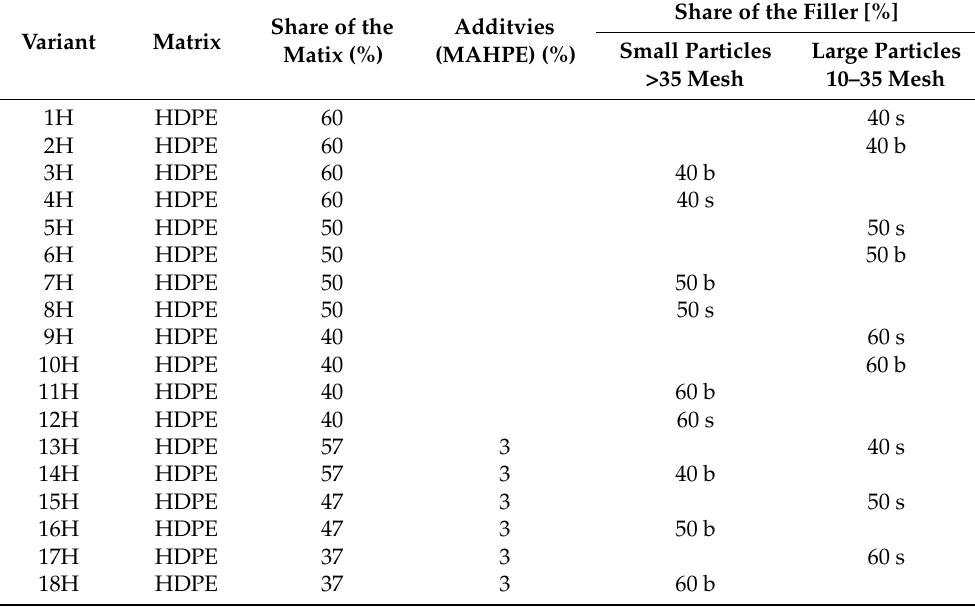
Table 2. Composition of individual variants HDPE